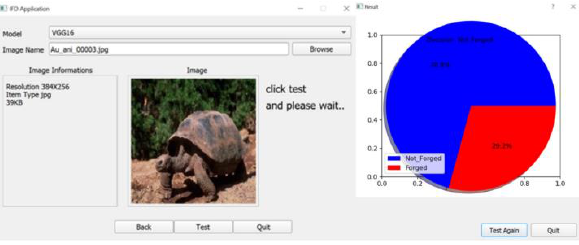
Figure 4. VGG16 Test Result